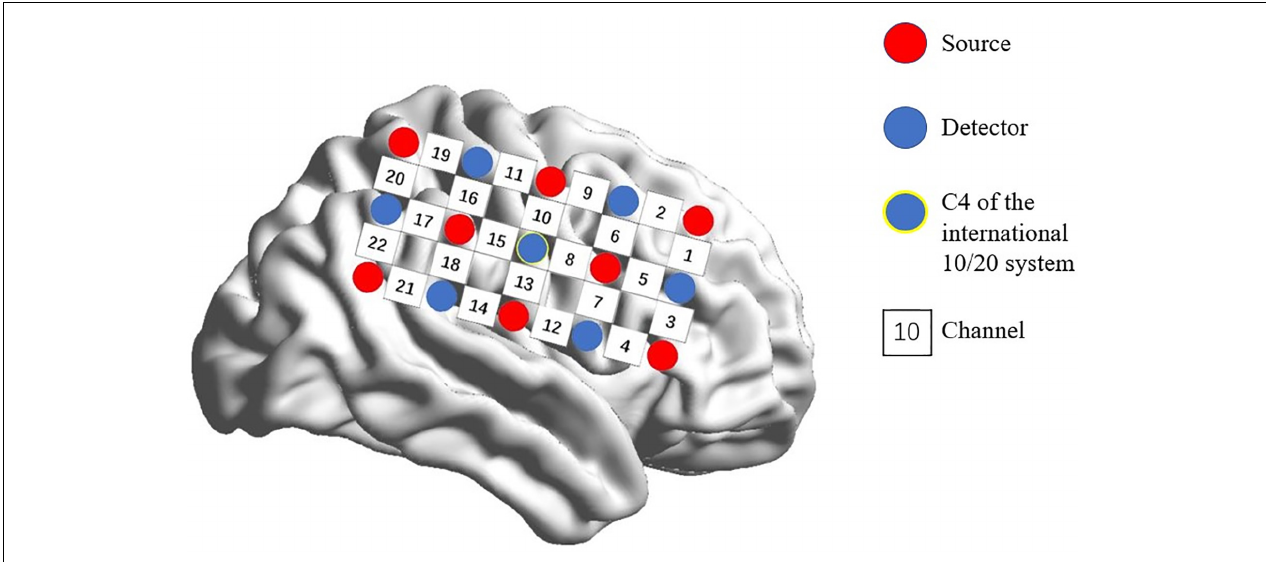
FIGURE 1 | Spatial profile of fNIRS probes. Red circles indicate the eight optical sources. Green circles indicate the seven detectors. Black numbers (1–22) indicate fNIRS channels. The optical sources and detectors were positioned on the international 10–20 standard positions.